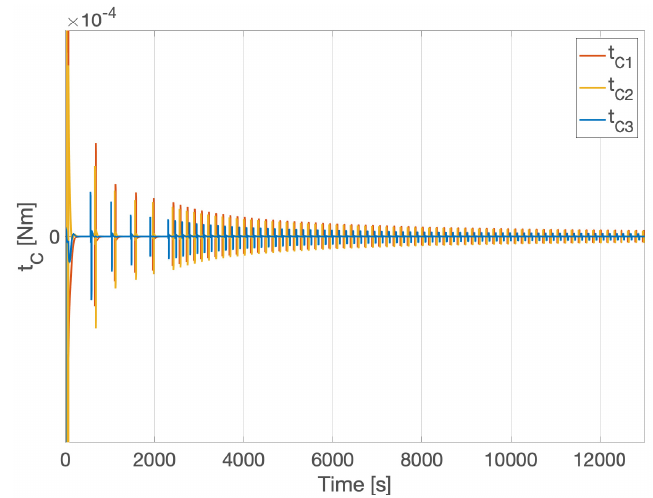
Figure 4. Control torques, with no